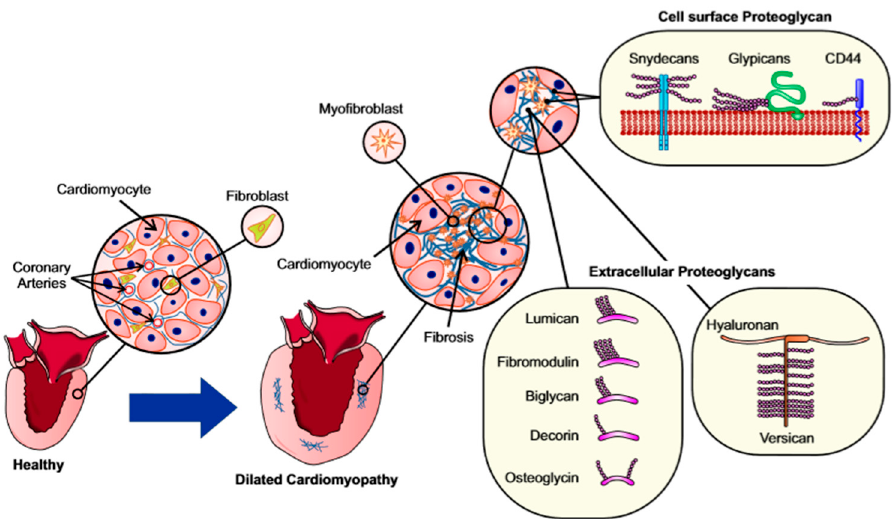
Figure 2. Accumulation of proteoglycans in addition to the fibrillar collagens in myocardial fibrosis. Myocardial remodeling in dilated cardiomyopathy entails enlargement of cardiomyocytes, increased amount of extracellular matrix and fibrosis. The proteoglycans present in fibrotic lesions can be extracellular or membrane-bound.